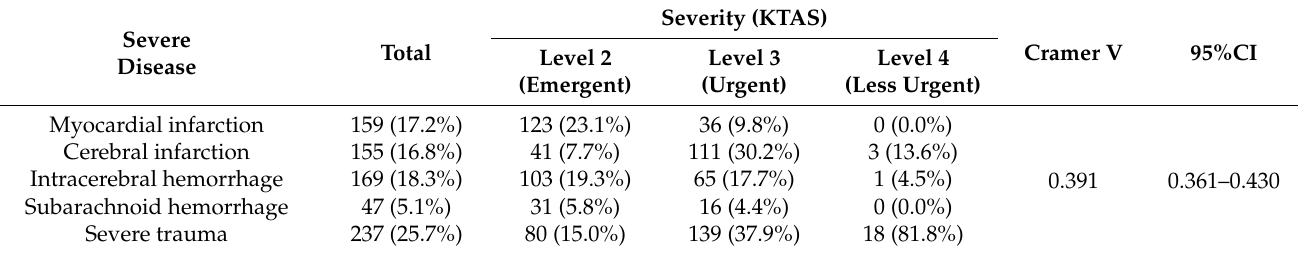
Table 5. Correlation between severe diseases and severity before the outbreak of COVID-19.